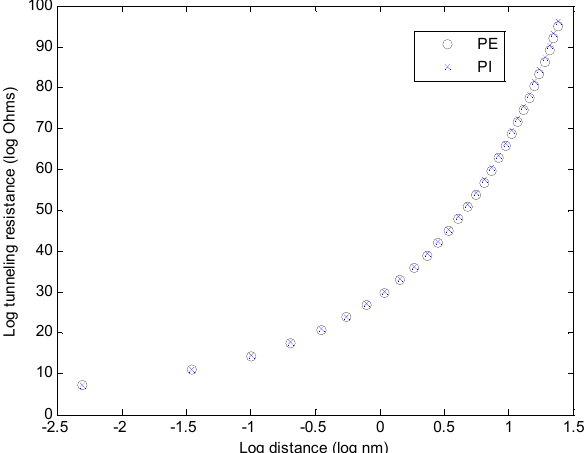
Figure 24. Tunneling resistance as a function of distance between nanotubes.